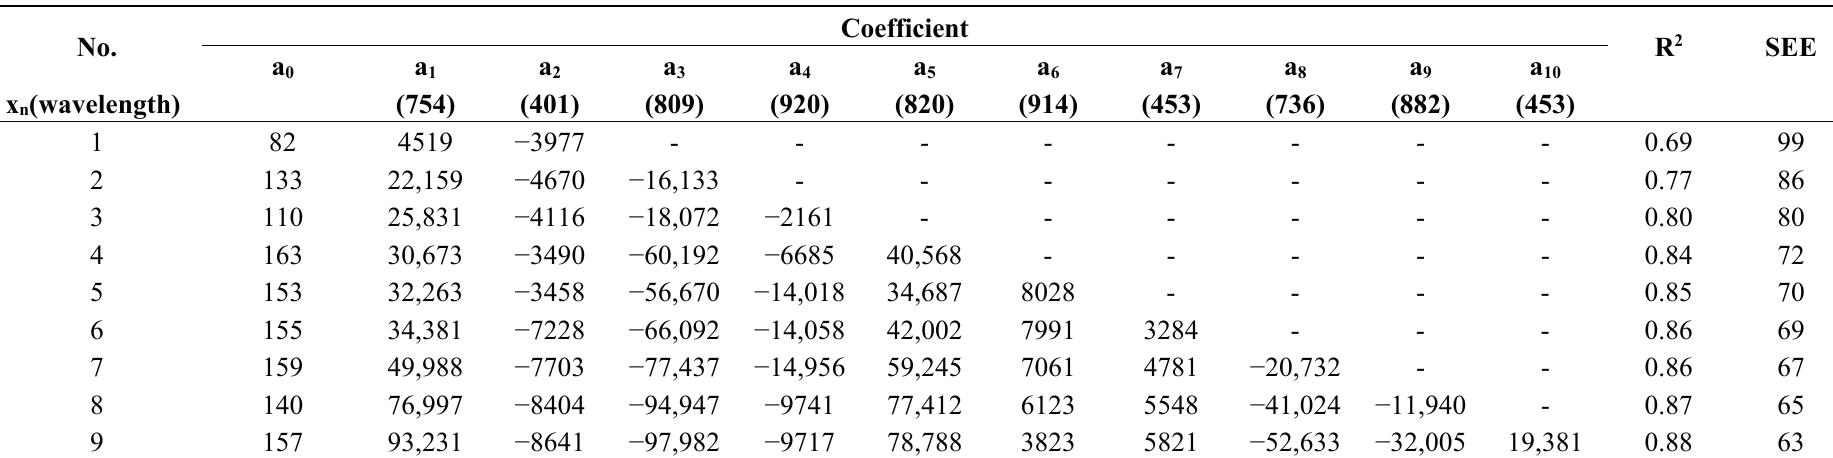
Table 3. Summary of MR and SEE model values for the statistical prediction of